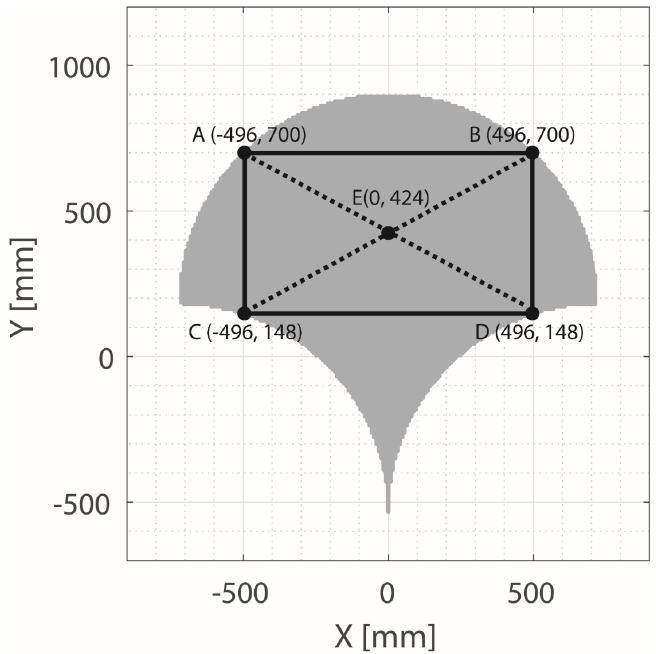
Figure 11. The considered critical positions ( A , B , C , D , and E points) within the mechanism workspace (in grey) with the reference rectangle. (in grey) with the reference